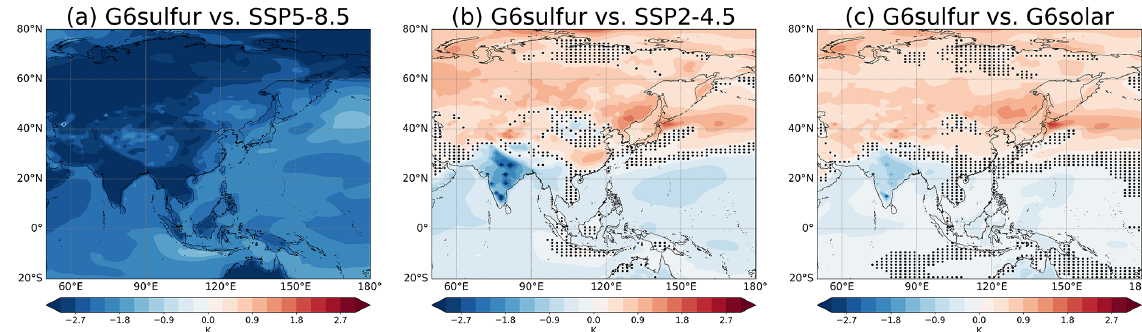
Figure 3. As in Fig. 2 but for the MJJAS mean surface temperature. Stippling indicates changes that are statistically insignificant ( p value > 0.05 based on Student’s t